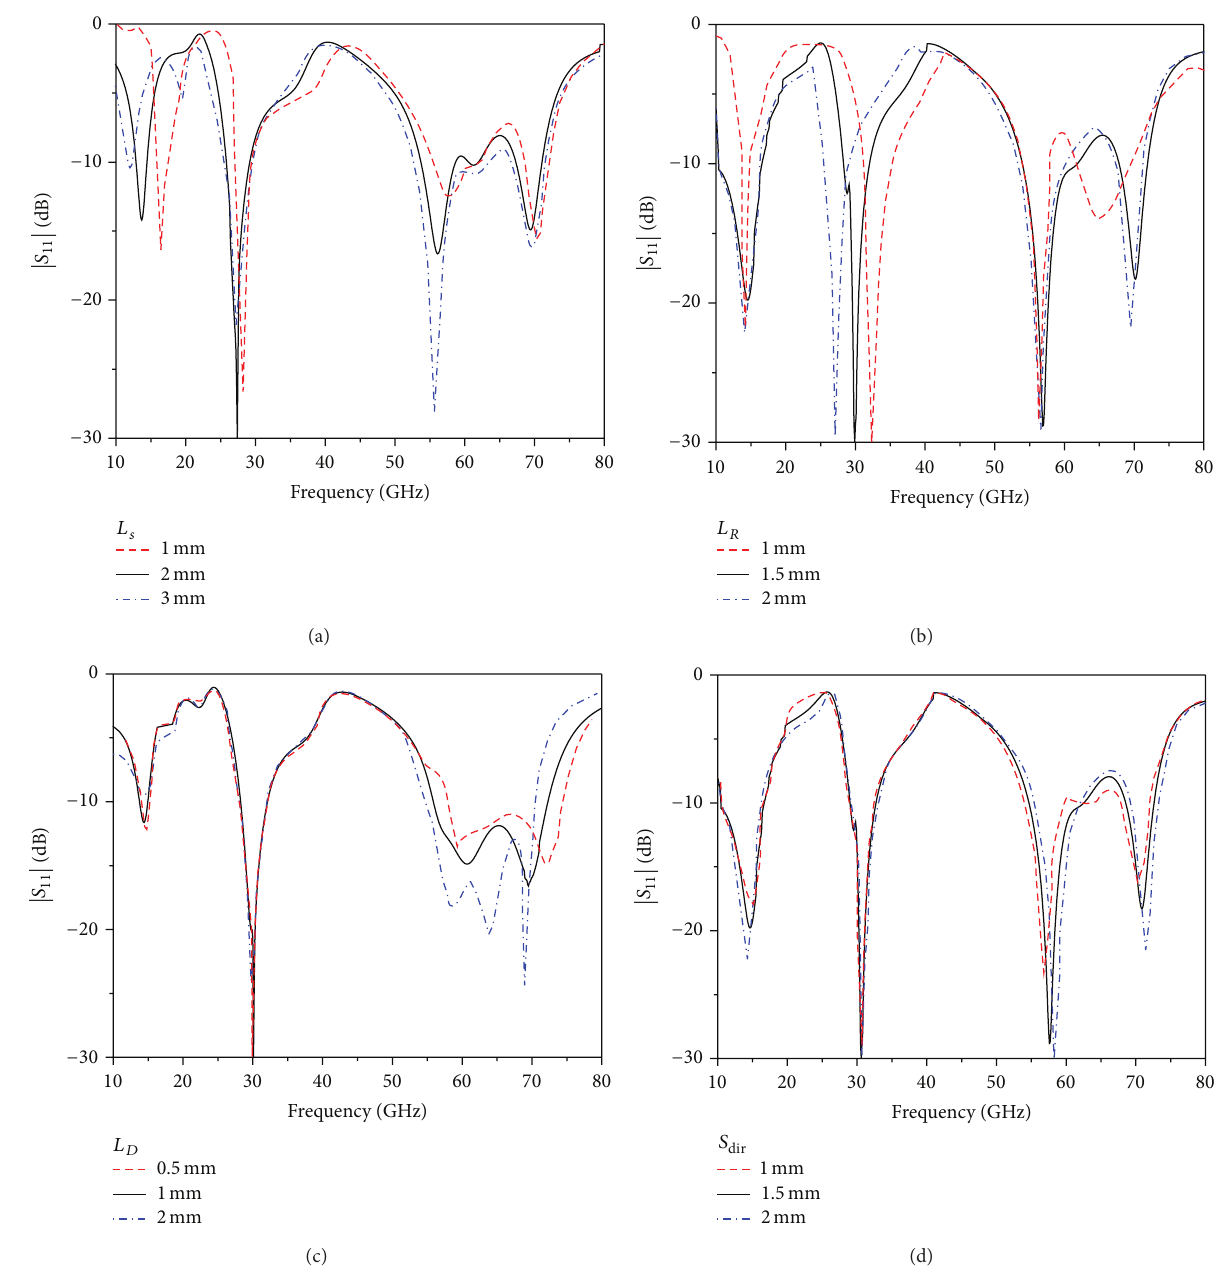
Figure 3: (a)–(d) |𝑆 11 | as function of 𝐿 𝑆 , 𝐿 𝑅 , 𝐿 𝐷 , and 𝑆